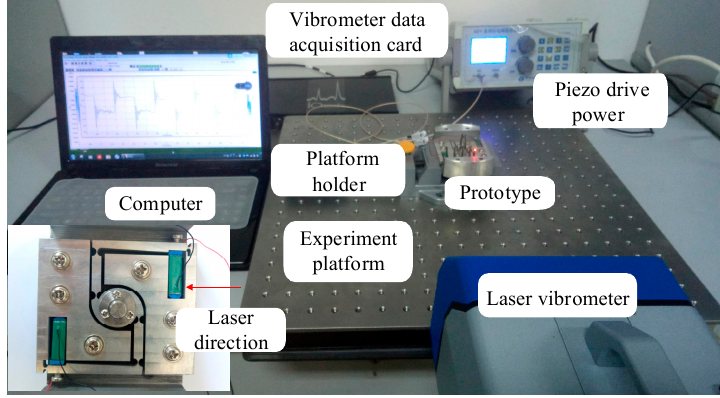
Figure 13. The experimental environment for measuring the free vibration.